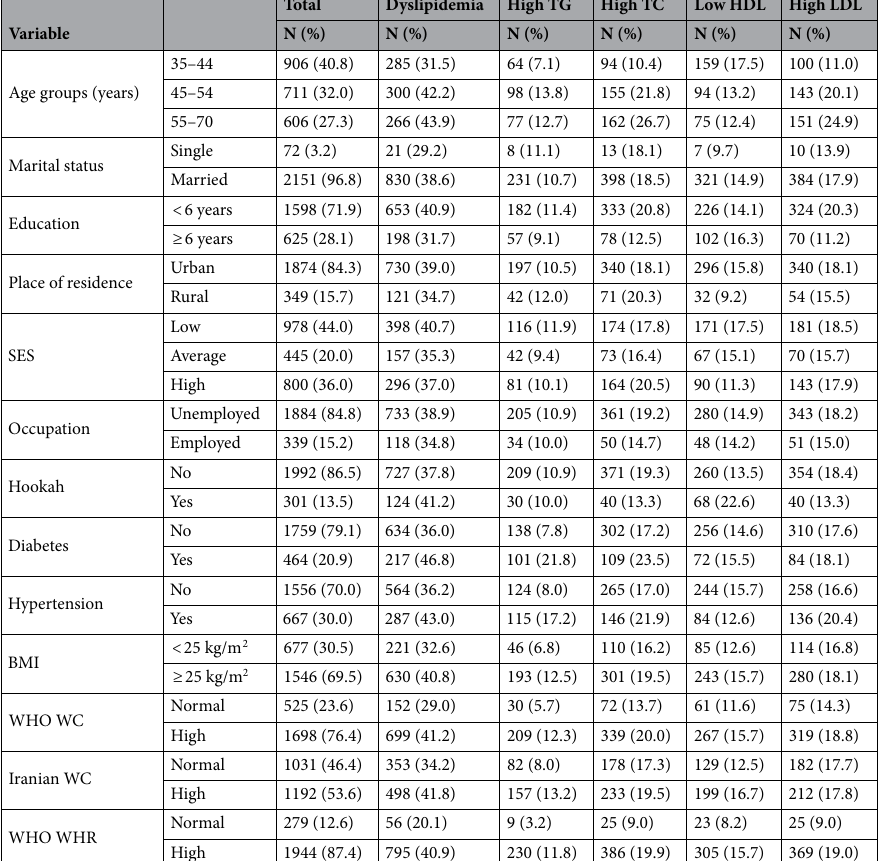
Table 1. Prevalence of dyslipidemia and individual lipid abnormalities. N, number; TG, triglyceride; TC, total cholesterol; HDL, high-density lipoprotein; LDL, low-density lipoprotein; SES, socioeconomic status; BMI, body mass index; WHO, World Health Organization; WC, waist circumference; WHR, waist-to-hip